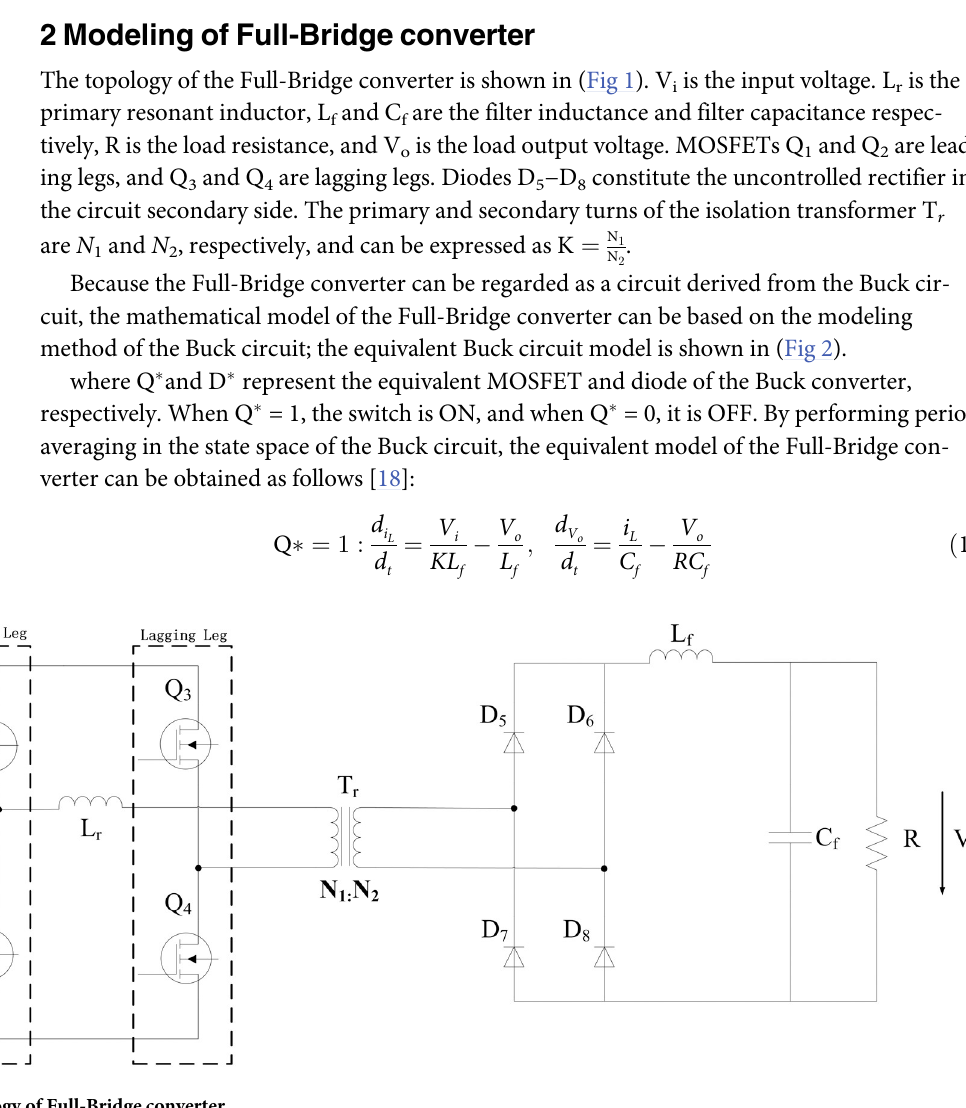
Fig 1. Basic circuit topology of Full-Bridge